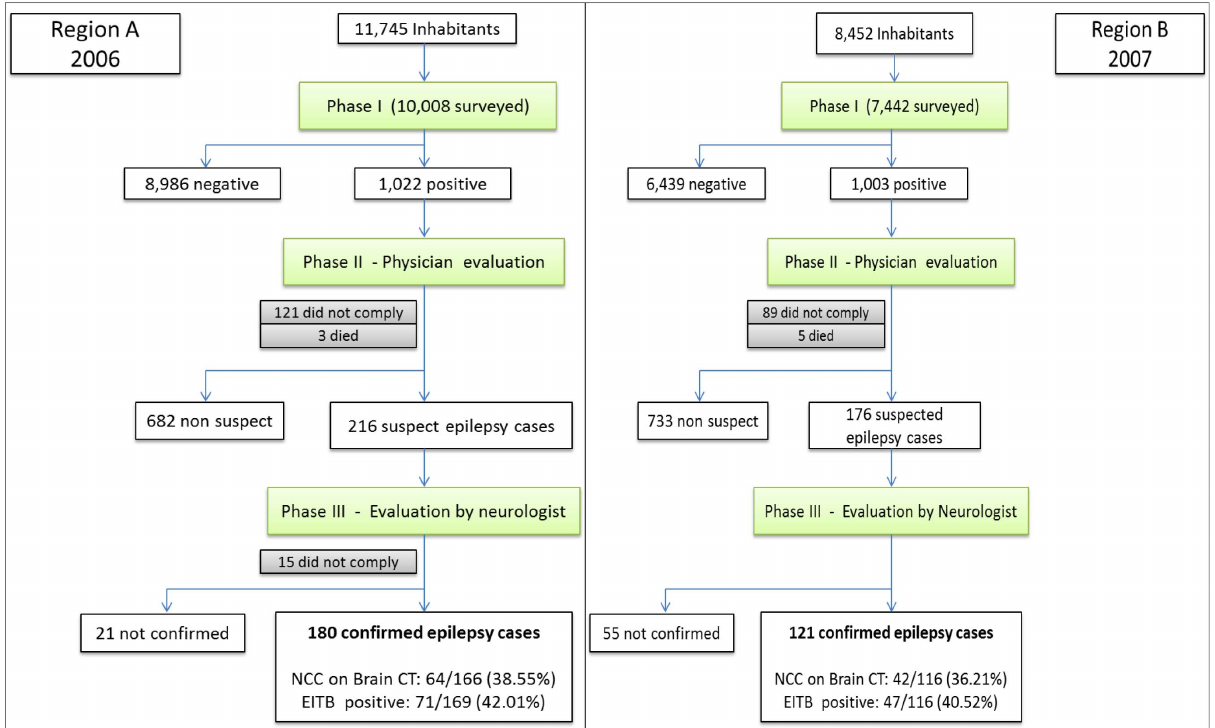
PLOS Neglected Tropical Diseases |